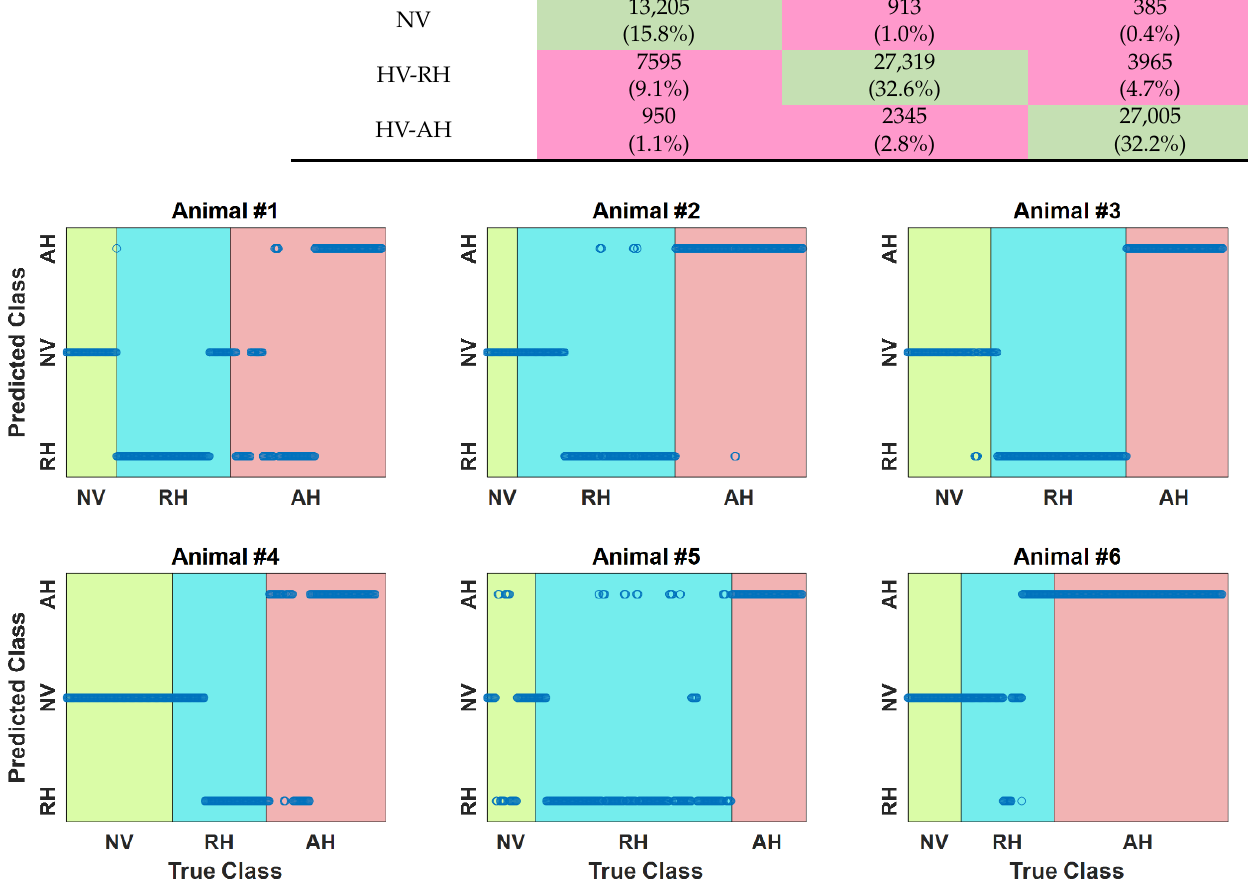
Figure 4. Time series sequences of multi-class blood volume decompensation state (normovolemia- relative hypovolemia-absolute hypovolemia) classification outcomes associated with all the animals in conjunction with the ground truth. Table 5. Comparison of final multi-class classifier and three competing ML classifiers (vital signs only, SCG-based features excluded, and BCG-based features excluded).